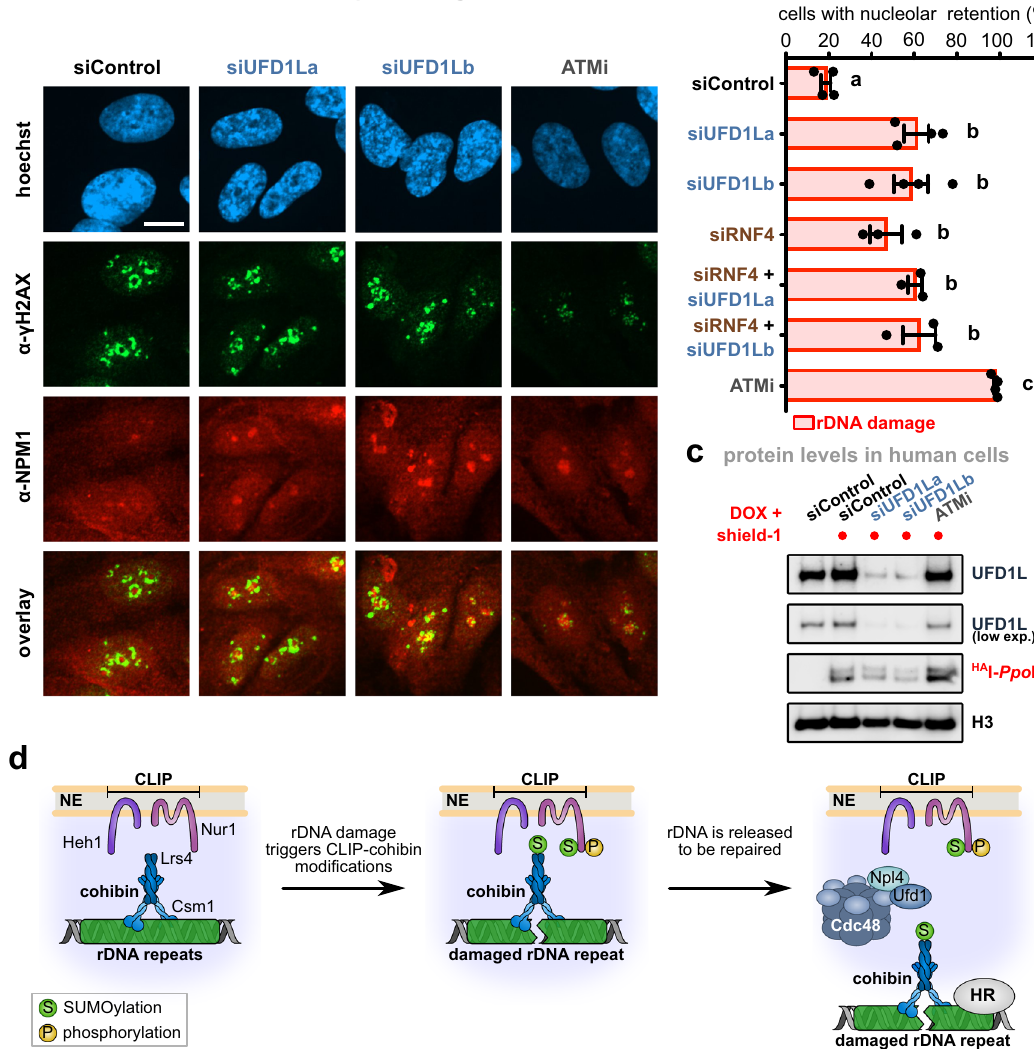
Fig. 8 Nucleolar segregation of broken repeats requires UFD1L in human cells. a Retention of rDNA locus (NPM1) in human cells upon DNA damage treated with siRNA against UFD1L. Human RPE cells stably expressing FKBP12- HA I- Ppo I were transfected with siRNAs against UFD1L (siUFD1La and siUFD1Lb), or treated with the ATM kinase inhibitor KU55933 (ATMi). Representative images of immuno fl uorescence staining after rDNA damage, using the indicated antibodies, are shown. Scale bar, 10 µ m. b Quanti fi cation of human RPE cells transfected with siRNA against a control (siControl; n = 4), RNF4 (siRNF4; n = 3), siUFD1L (siUFD1La and siUFD1Lb; n = 4), combination thereof ( n = 3), or ATMi treated ( n = 4), showing the percentage of cells with nucleolar retention of γ H2AX foci. Data are mean ± SEM of n biologically independent experiments. Statistical analysis was performed using ANOVA, and letters denote signi fi cant differences with a Tukey ’ s post hoc test at P ≤ 0.05. c Immunoblot of RPE cells from Fig. 7a after rDNA damage, showing